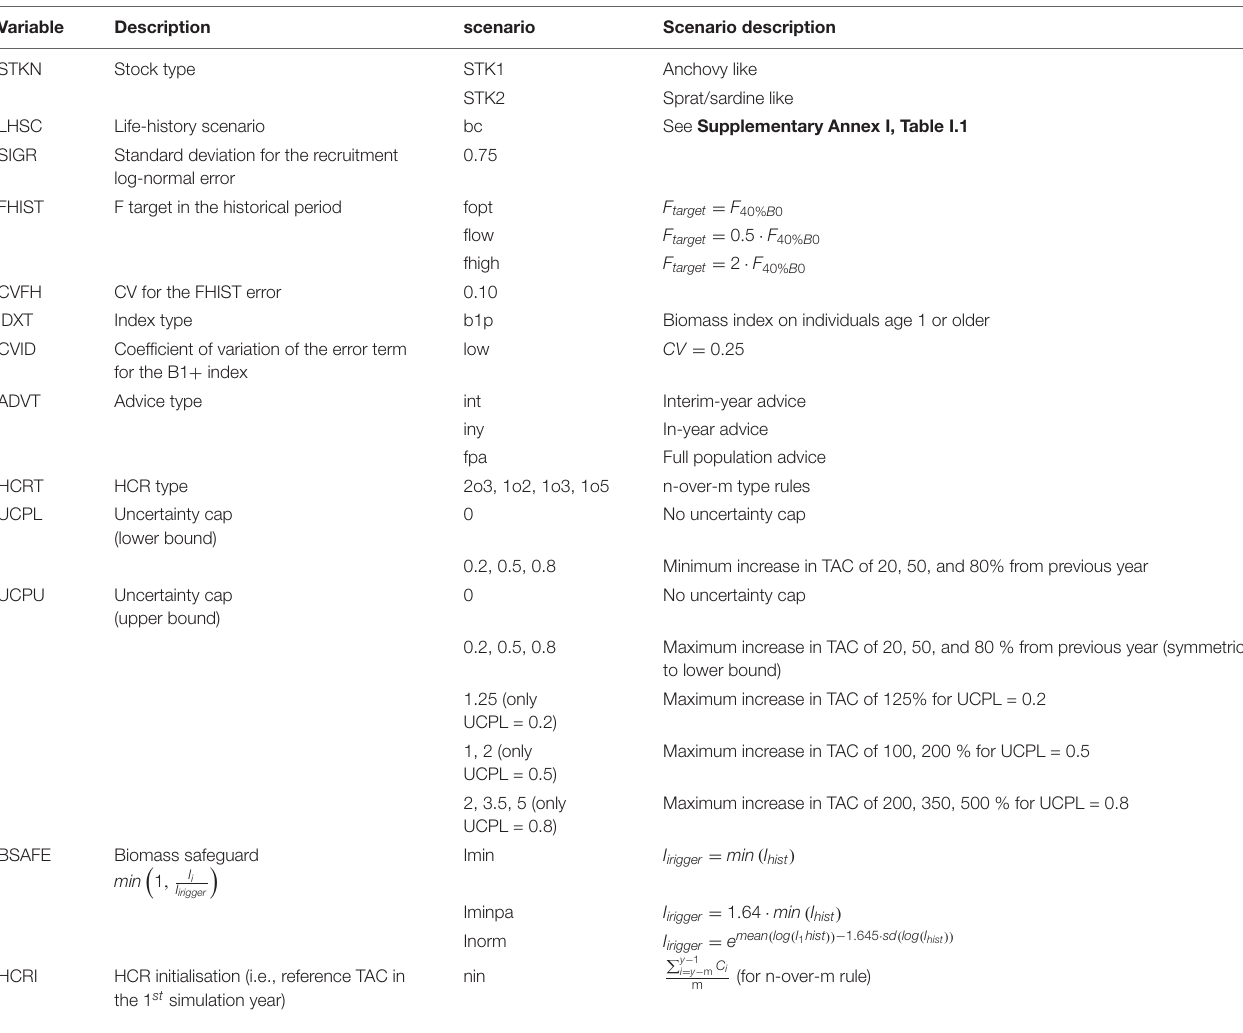
TABLE 1 | List of alternative scenarios simulated for the different components.